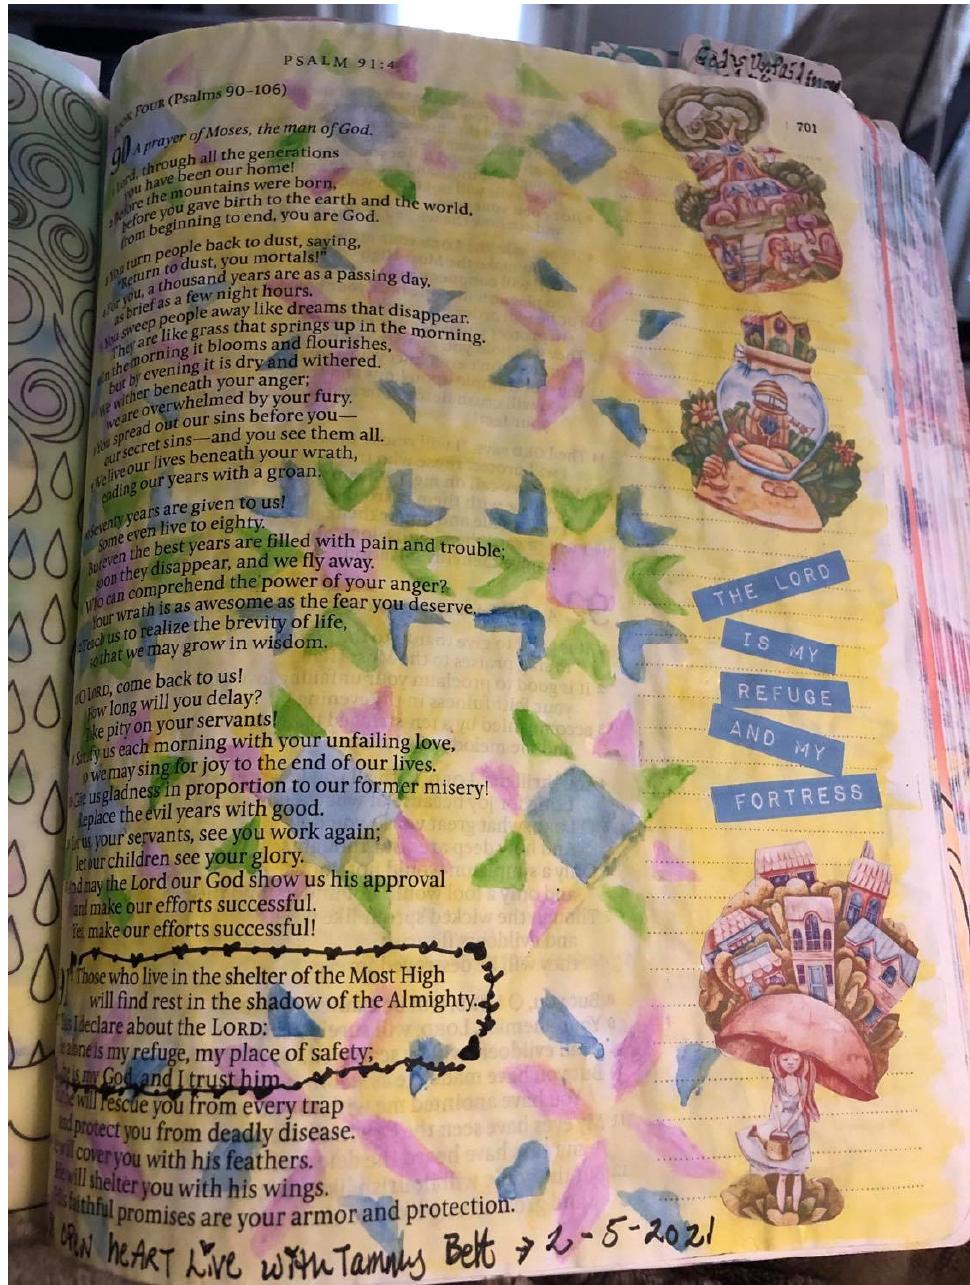
Figure 10. Psalm 91:1-2. With kind permission of the journaler.